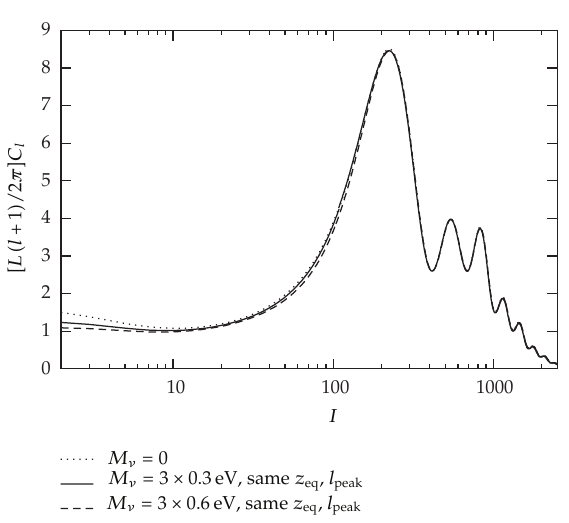
Figure 8: CMB temperature spectrum with di ff erent neutrino masses. Some of the parameters of the Λ MDM model have been varied together with M ν in order to keep fixed the redshift of equality and the angular diameter distance to last